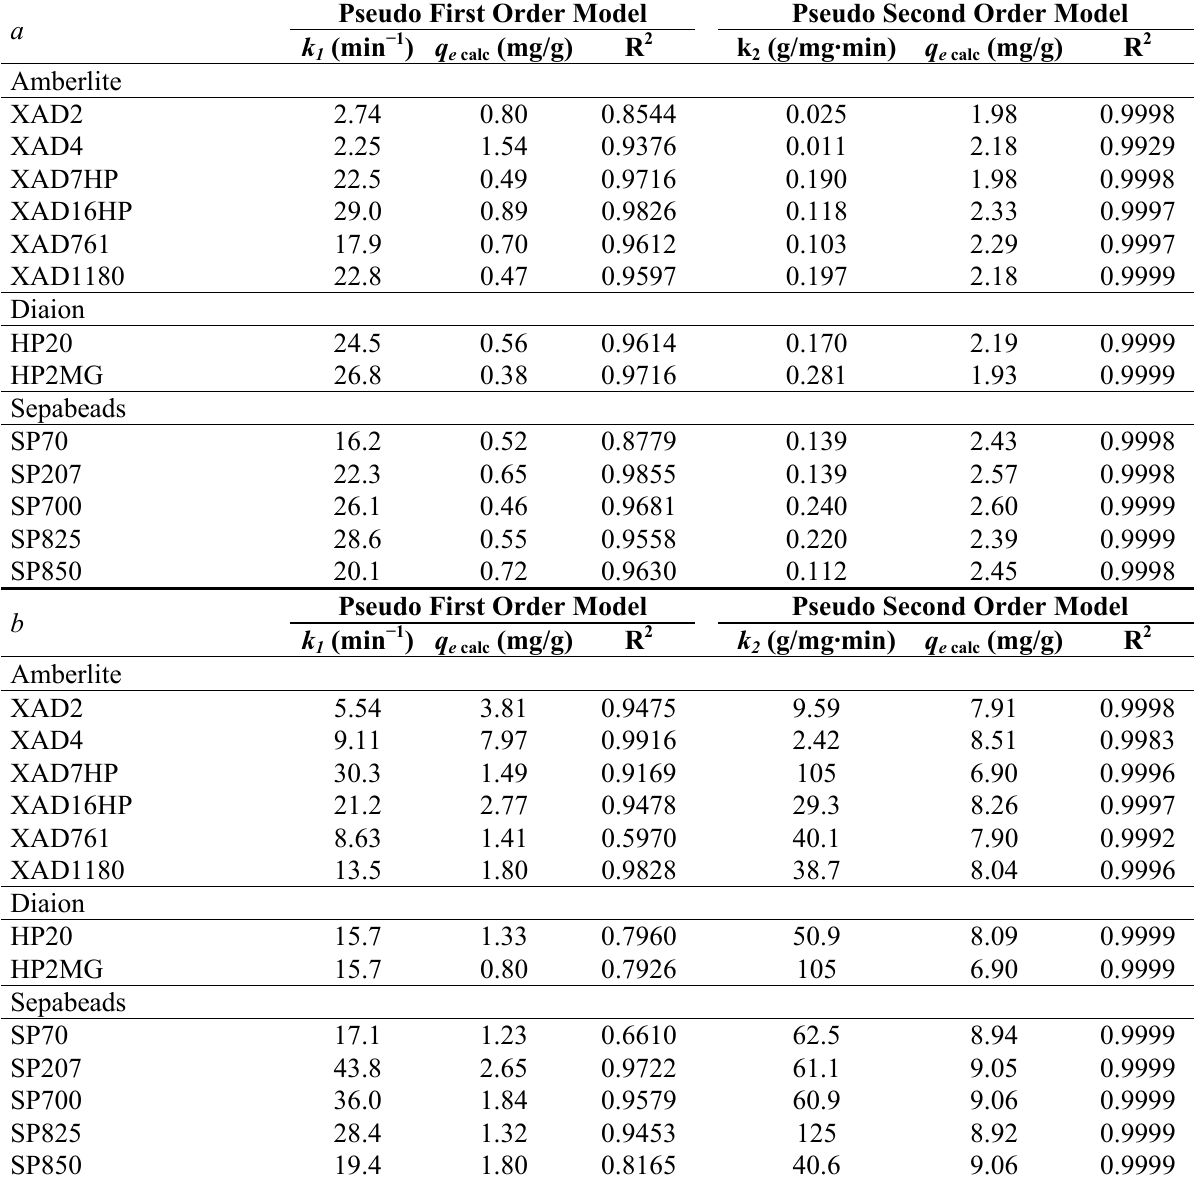
Table 1. Regression coefficients for pseudo first and pseudo second order models for